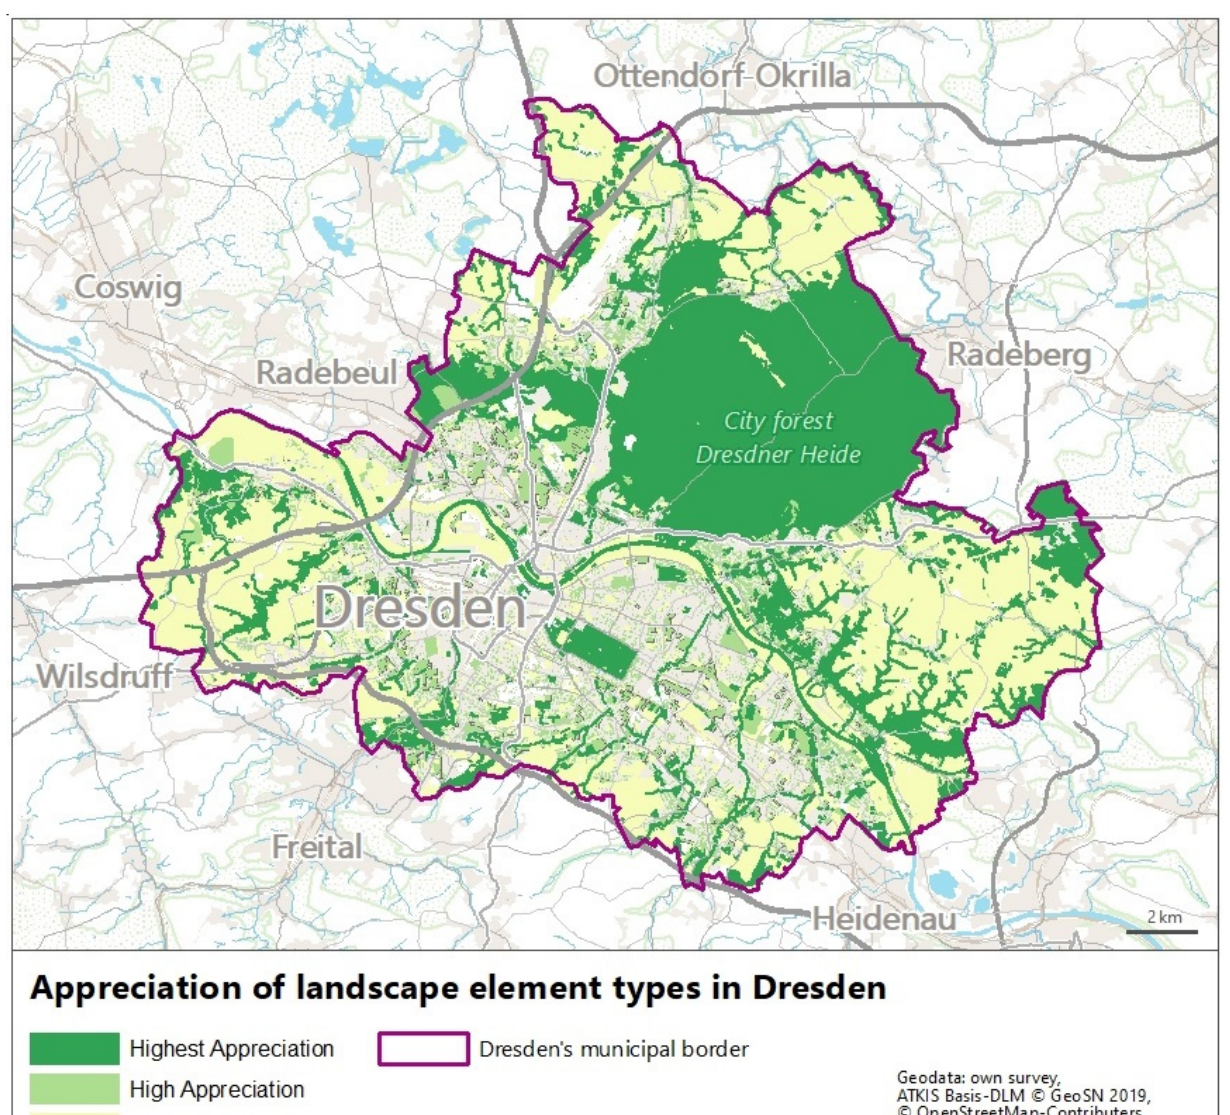
Figure 9. Map of preferred landscape elements in Dresden as potential areas to expand the recreational ecosystem service (source: authors’ elaboration).